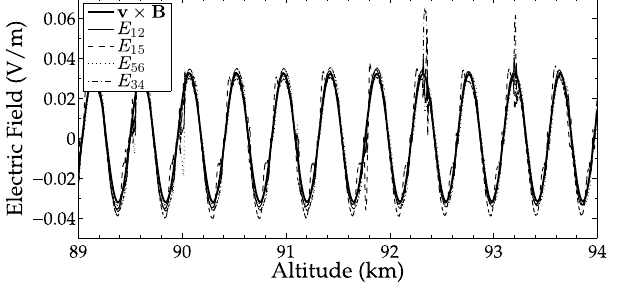
Fig. 3. Electric fields measured by several pairs of probes over a 5km region above the NLC layer. These are compared to the ex- pected induced v × B electric field, calculated using the measured v and B . The 2Hz oscillation is due to rotation of the rocket. This shows that different pairs of probes, with different probe separa- tions, in the front and aft of the rocket all measure the same expected DC electric field above the NLC